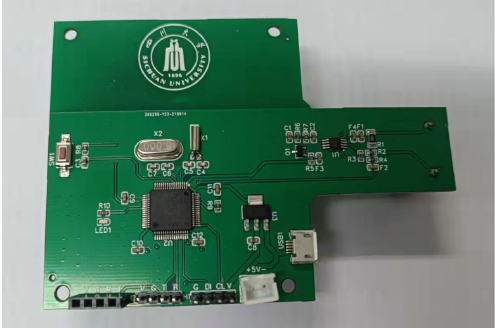
Figure 5. The circuit board of current sampling and signal conditioning based on the current